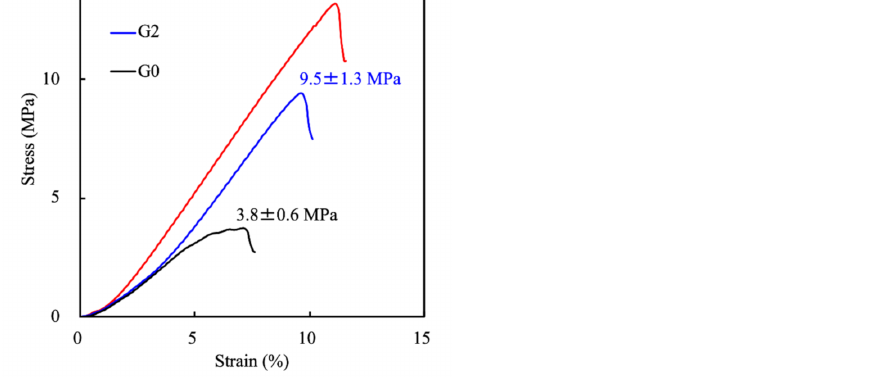
Figure 3. Stress-strain curve of G0, G2, and G5 scaffolds. Data presented as mean ± SEM, n = 6 for each